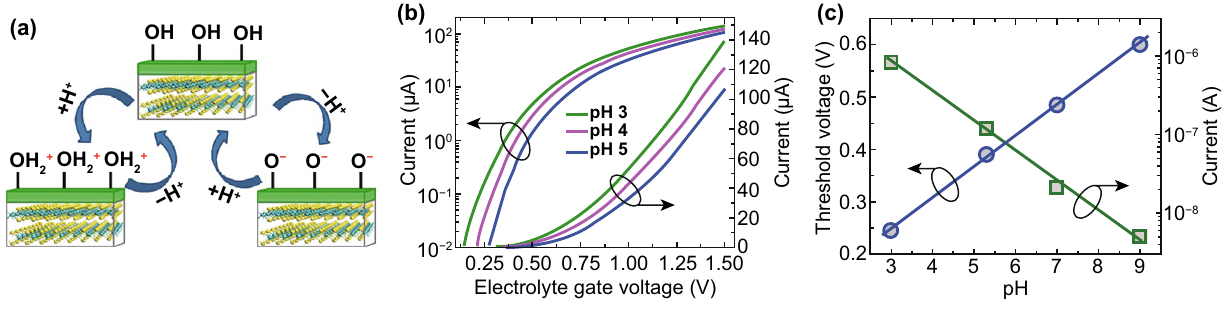
Fig. 5 2D TMDC FET pH sensors. a Illustration of surface chemistry of channel in pH sensing: the protonation/deprotonation of OH group on the dielectric surface at a low/high pH leads to a positive/negative surface charge on channel. b Drain current of the sensor is plotted as a func- tion of gate voltage with different pH values. c Changes of threshold voltage (left axis) and current (right axis) of MoS 2 FET at a wide range of pH (3–9). Reprinted with permission from Ref. [81], Copyright 2014, American Chemical